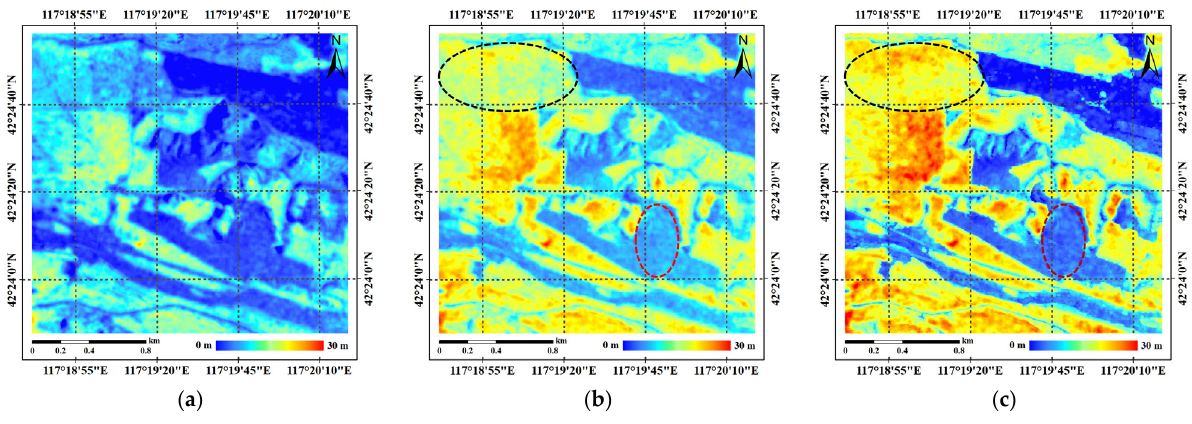
Figure 16. Forest height estimation results: ( a ) H X-InSAR; ( b ) H X-IDUV; ( c ) H X-MLM .